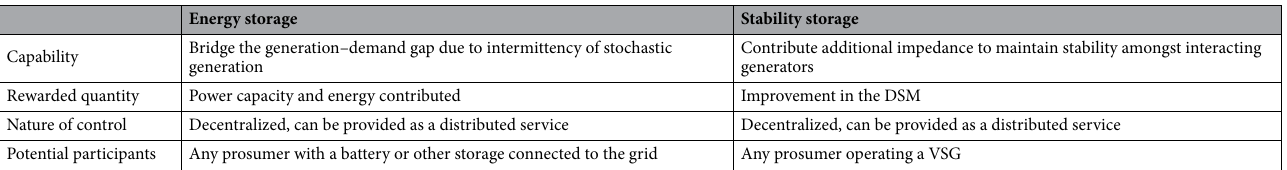
Table 1. Analogy between energy storage and stability